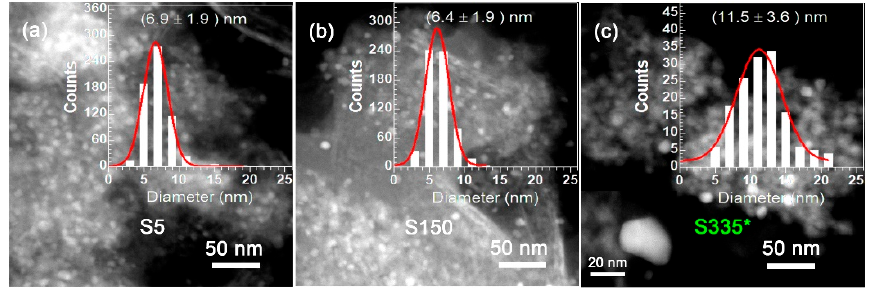
Figure 7. STEM images for the spent Ni/MgAl 2 O 4 -E catalyst: ( a ) Ni/MgAl 2 O 4 -S5, ( b ) Ni/MgAl 2 O 4 - S150 and ( c ) Ni/MgAl 2 O 4 -S335*.